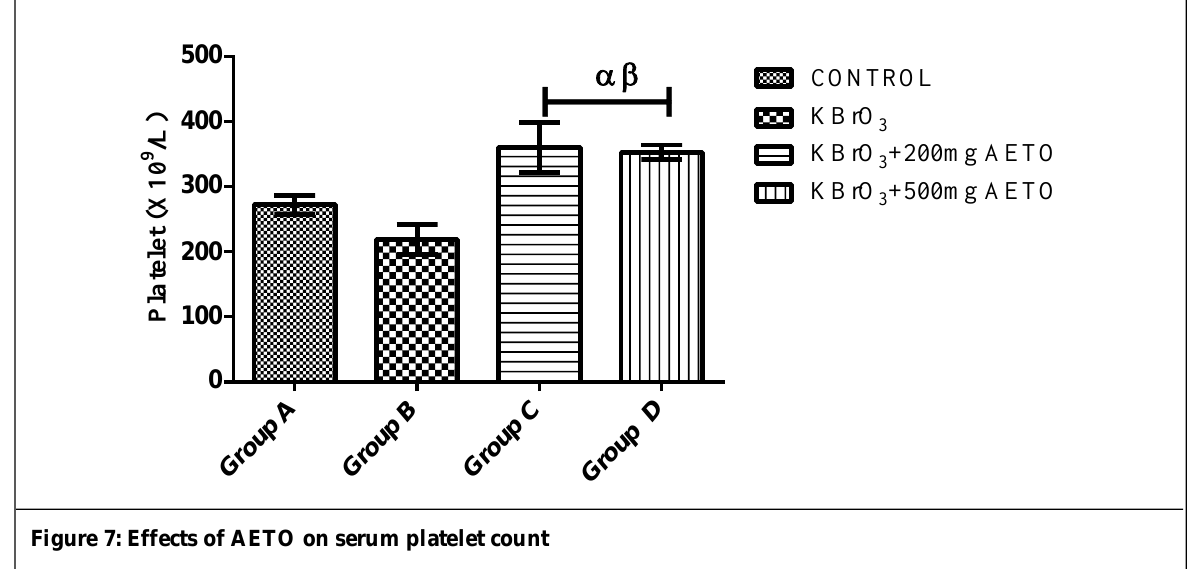
Figure 7: Effects of AETO on serum platelet count Note: Value of p < 0.05 was considered significant. The values with superscript  = significantly different from group A,  = significantly different from group B. PLT - Platelet.